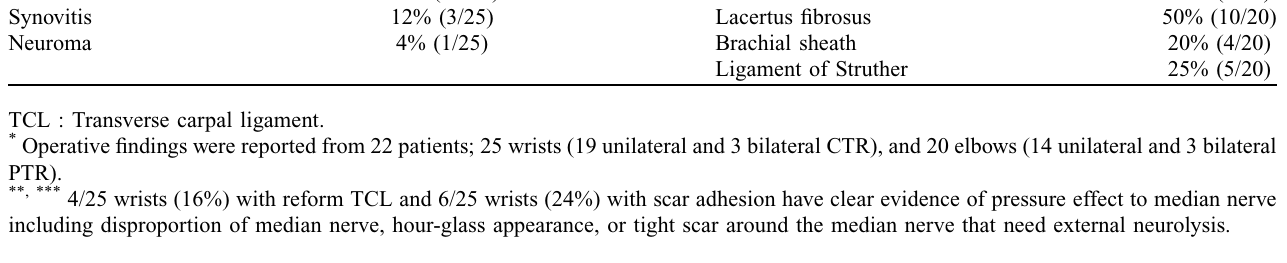
Table 3. Surgical outcomes of surgical treatment between two groups.